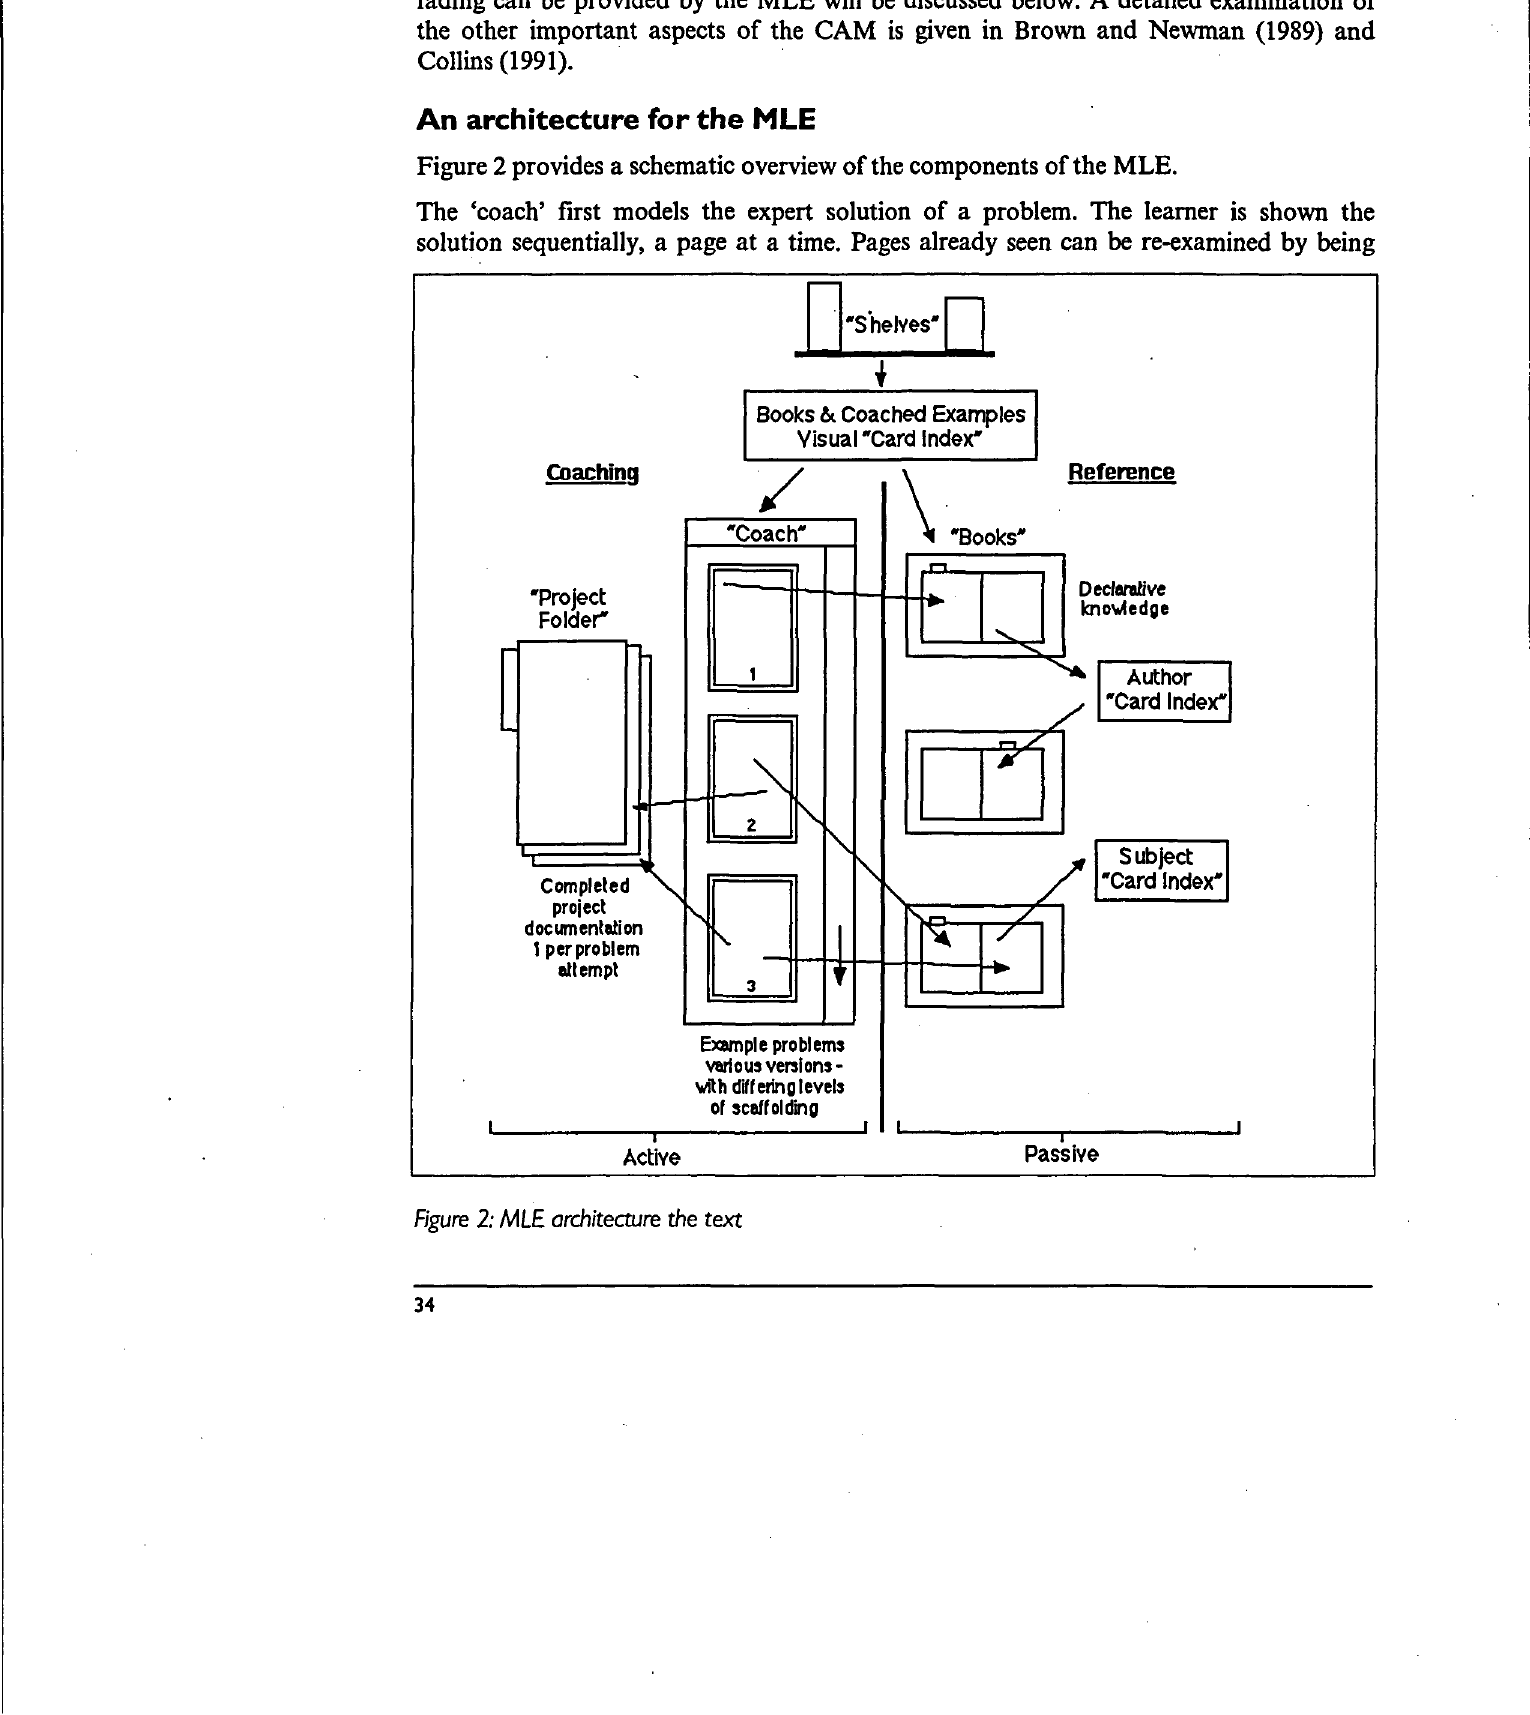
Figure 2: MLE architecture the